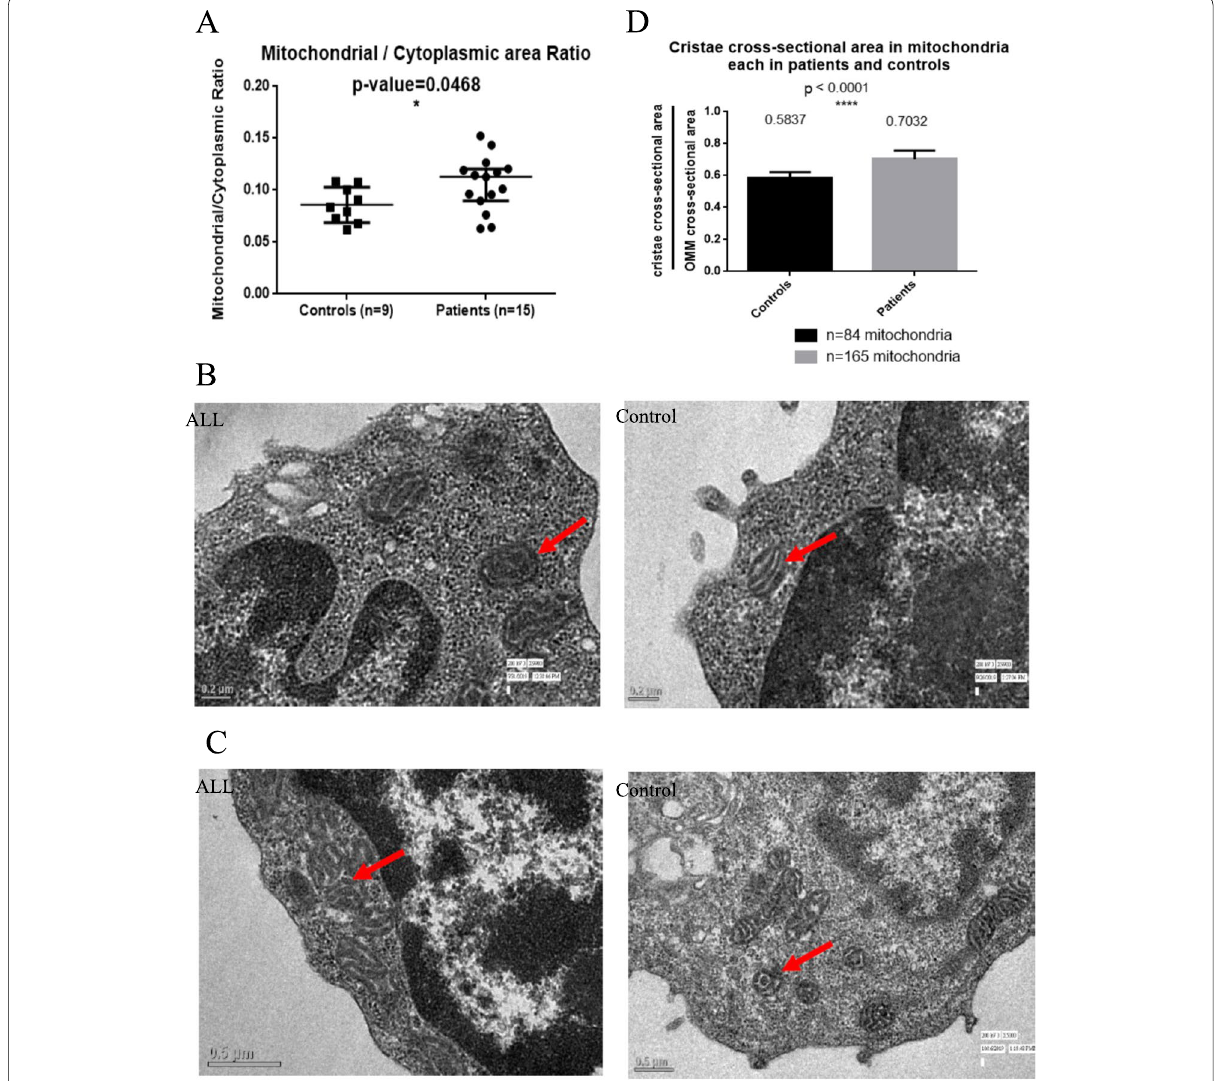
Fig. 3 A Scatter plot representation of average M/C ratio in ALL patients ( n were analyzed for qualitative differences between ALL patients and healthy controls; arrow depicting mitochondria in the TEM images. B Thicker and denser cristae in mitochondria in lymphoblast of a T-ALL patient (left; 9900X; scale bar (right; 9900X; scale bar 0.2 μm). C Thicker and denser cristae in mitochondria in lymphoblast of a B-ALL patient (left; 5000X; scale bar = as compared to lymphocyte of patient’s sibling (right; 5000X; scale bar mitochondria ( n 165) of lymphoblasts of 15 ALL patients versus mitochondria ( n = depicted on top of the bars in each group; p < 0.0001. These numbers 165 and 84 suggests multiple mitochondria in each section were analysed in ALL patients and controls (* p < 0.05, ** p < 0.01, *** p < 0.001, Mann-Whitney U test). OMM- Outer Mitochondrial